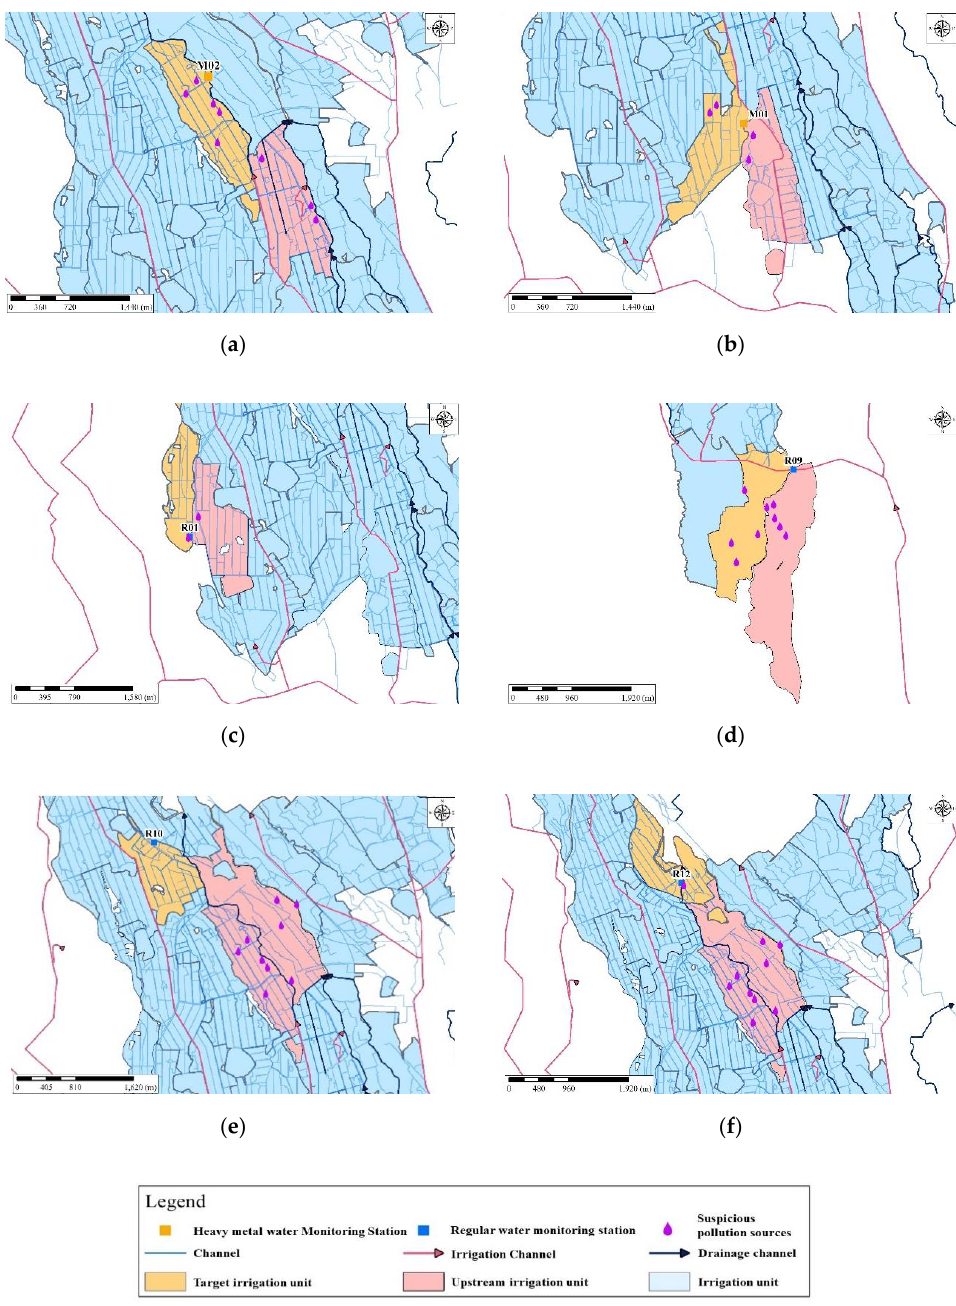
Figure 8. Pollution pathways of upstream and downstream irrigation units for ( a ) Case 1 (Type I); ( b ) Case 3 (Type I); ( c ) Case 4 (Type II); ( d ) Case 5 (Type III); ( e ) Case 6 (Type IV); ( f ) Case 8 (Type